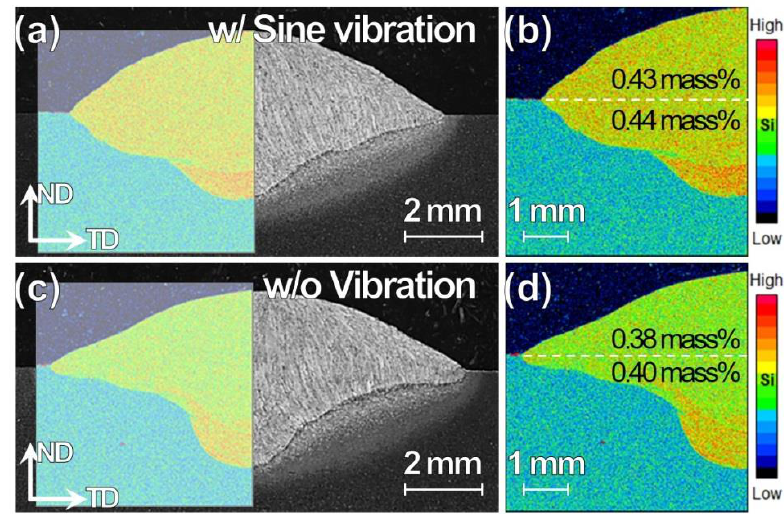
Figure 7. Cross-sectional ( a ), ( c ) OM images and ( b ), ( d ) electron probe microanalyzer (EPMA)-Si maps for TP-GMAW specimens at 1.2 m/min ( a ), ( b ) w/ and ( c ), ( d ) w/o sine vibration (F = 250 Hz, G = 1.2 m/s 2 and T = 30 s).